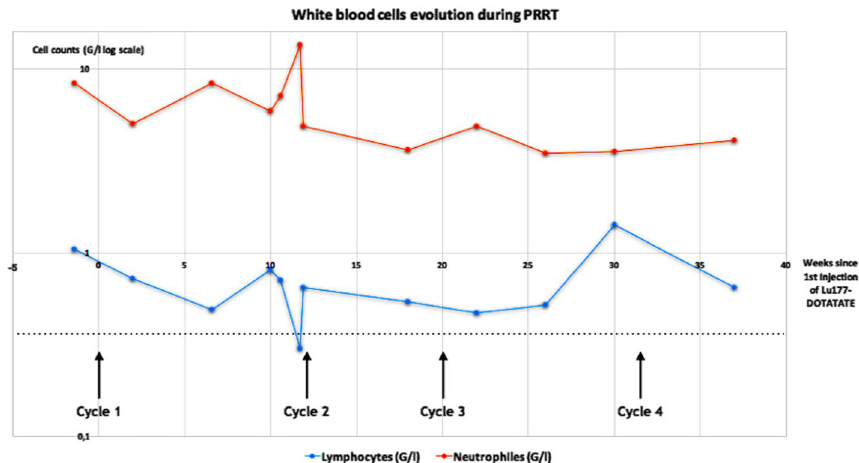
Fig. 1 Changes in white blood cell counts during PRRT (lymphocytes (blue) and neutrophils (orange); logarithmic scale); dotted line: definition of severe lymphopenia (value < 0.5G/l); * in red: values for CRP (mg/